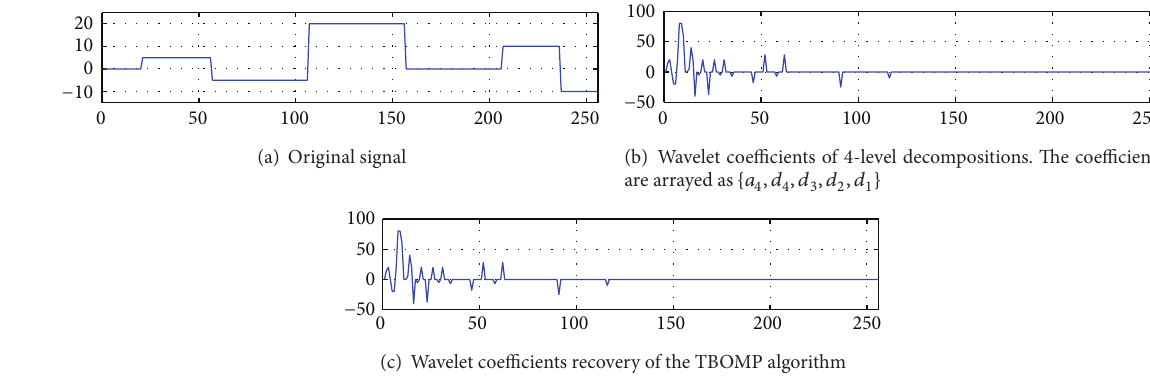
Figure 3: Reconstruction signal by TBOMP algorithm.